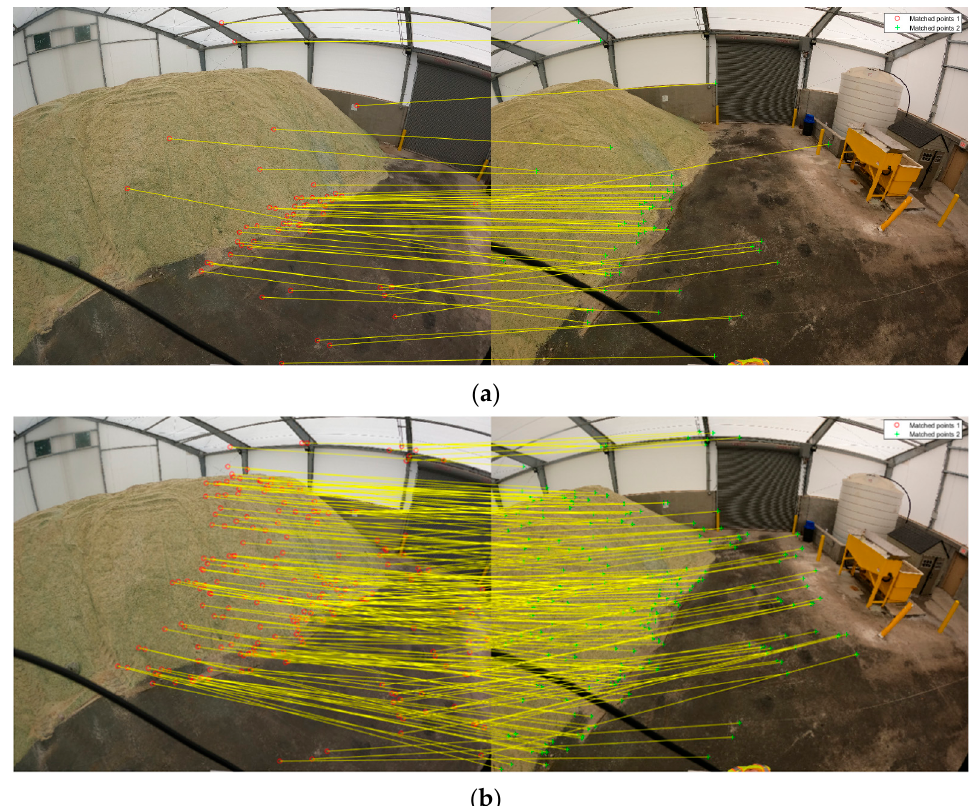
Figure 16. Sample matching results for a stereo-pair in the US-231 dataset: ( a ) rotation-constrained matching after one iteration with 513 matches and projection residual of 230 pixels and ( b ) rotation- constrained approach after two iterations with 2127 matches and projection residual of 25 pixels (for a better visualization, only 10% of matches are illustrated).